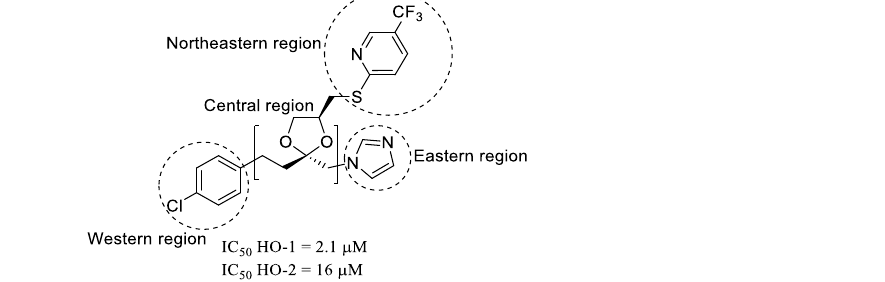
Figure 1. Chemical structure and IC 50 values of representative HO-1 and HO-2 inhibitors (QC-80).